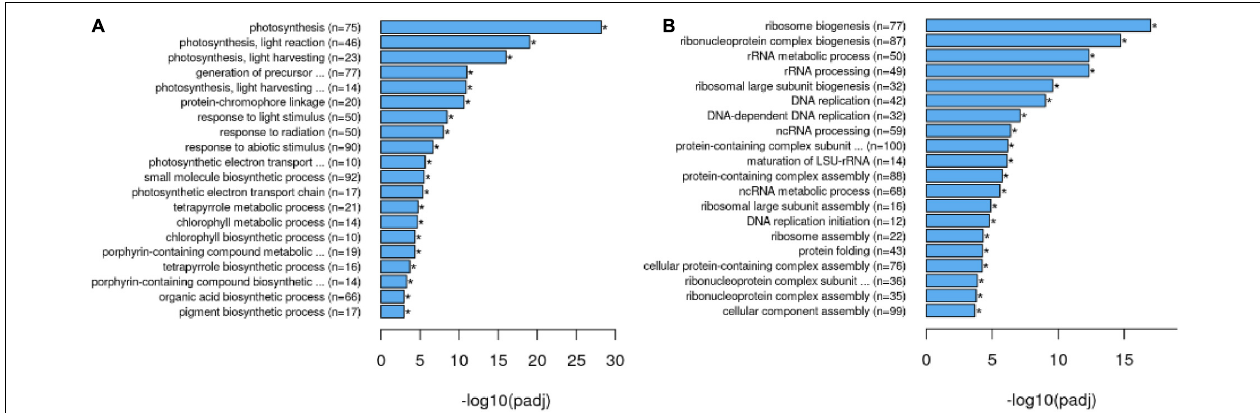
FIGURE 3 | Overrepresentation analysis of GO biological processes among genes differentially expressed between 35S:nahG and WT in LTMH. Top categories are indicated among (A) DEGs that are higher expressed in 35S:nahG than in WT ( Supplementary Table 6 ) and (B) DEGs that are lower expressed in 35S:nahG than in WT ( Supplementary Table 7